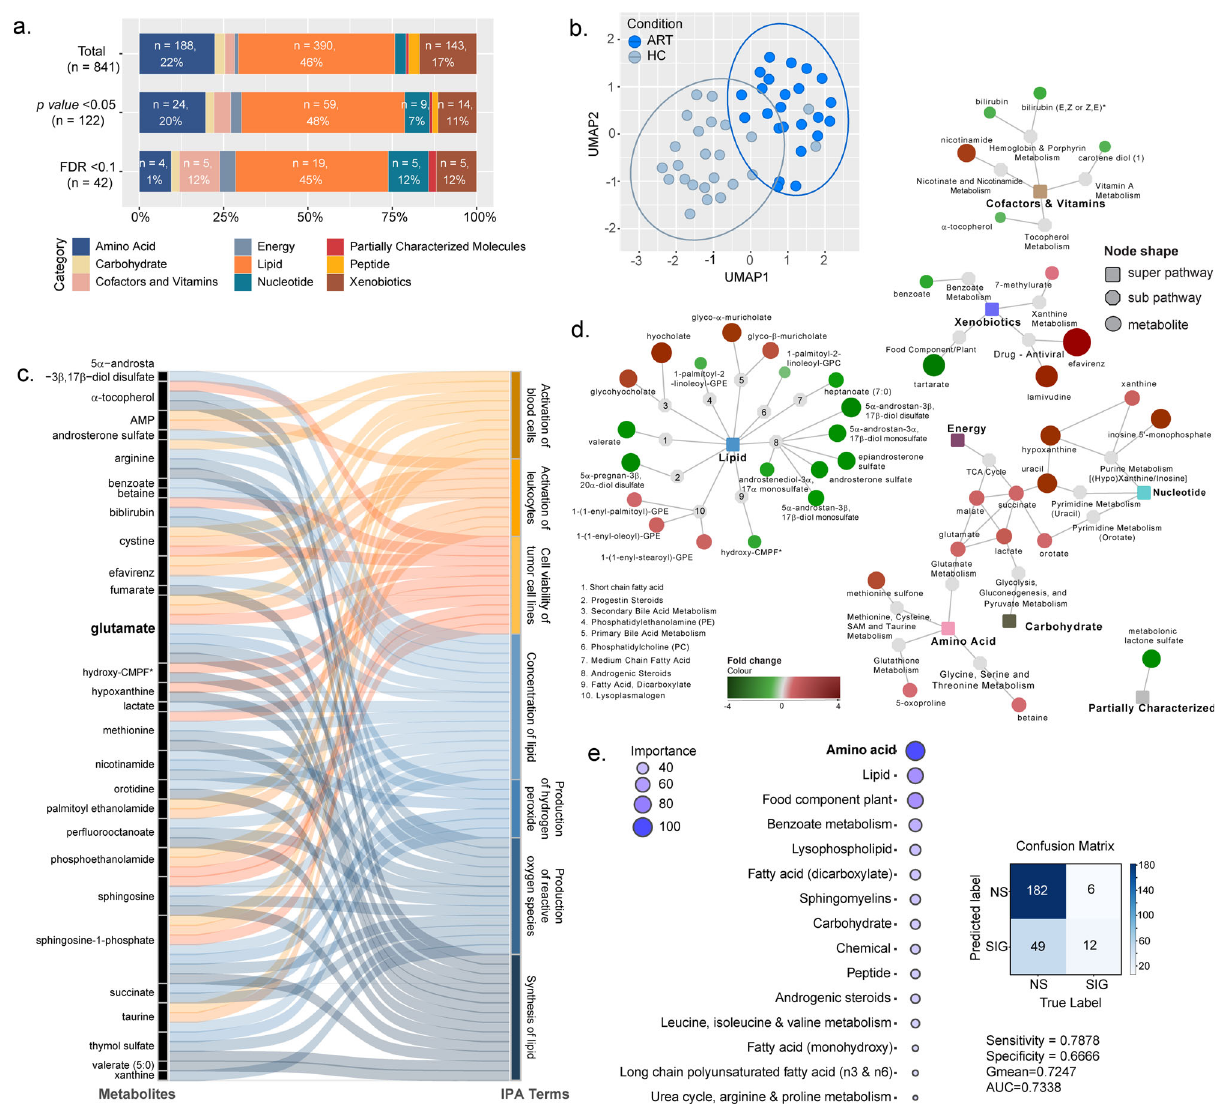
Fig. 1 Untargeted metabolomics in the Cameroon cohort highlight substantial metabolic alterations in cART compared with HC. a Bar plots representing the proportion of super pathways and number of associated metabolites in total detected metabolites ( n = 841), metabolites with differential abundance between HC and PLWH on cART with p < 0.02 (Mann – Whitney U-Test, n = 122) and FDR < 0.1 (Mann – Whitney U -test, n = 42). b UMAP visualization of 48 samples using metabolites differing between HC and PLWH on cART (Mann – Whitney U -test, FDR < 0.1, n = 42). Samples are colored by condition (light blue = HC; dark blue = cART). c Sankey Plot illustrating the most important contribution to the fl ow of glutamate-associated pathways together with metabolites that are altered in cART patients. d Network of the metabolites signi fi cantly differing between HC and cART (Mann – Whitney U - t est, FDR < 0.1, n = 42). Colored rectangular nodes represent super pathways, gray circles subpathways, and colored circles single metabolites. The color gradient was applied depending on log2FC for each metabolite from green (decreased in cART) to red (increased in cART). The size of the bubble is proportional to log2FC. Edges connect each metabolite to its respective subpathway and each subpathway to its respective super pathway. e Bubble plot showing the importance of Metabolon pathways in the prediction of metabolite association with cART status and the associated confusion matrix and classi fi er metrics. Terms represented at the top of the fi gure are the most important for prediction. (RF, estimators: 500, class weight: